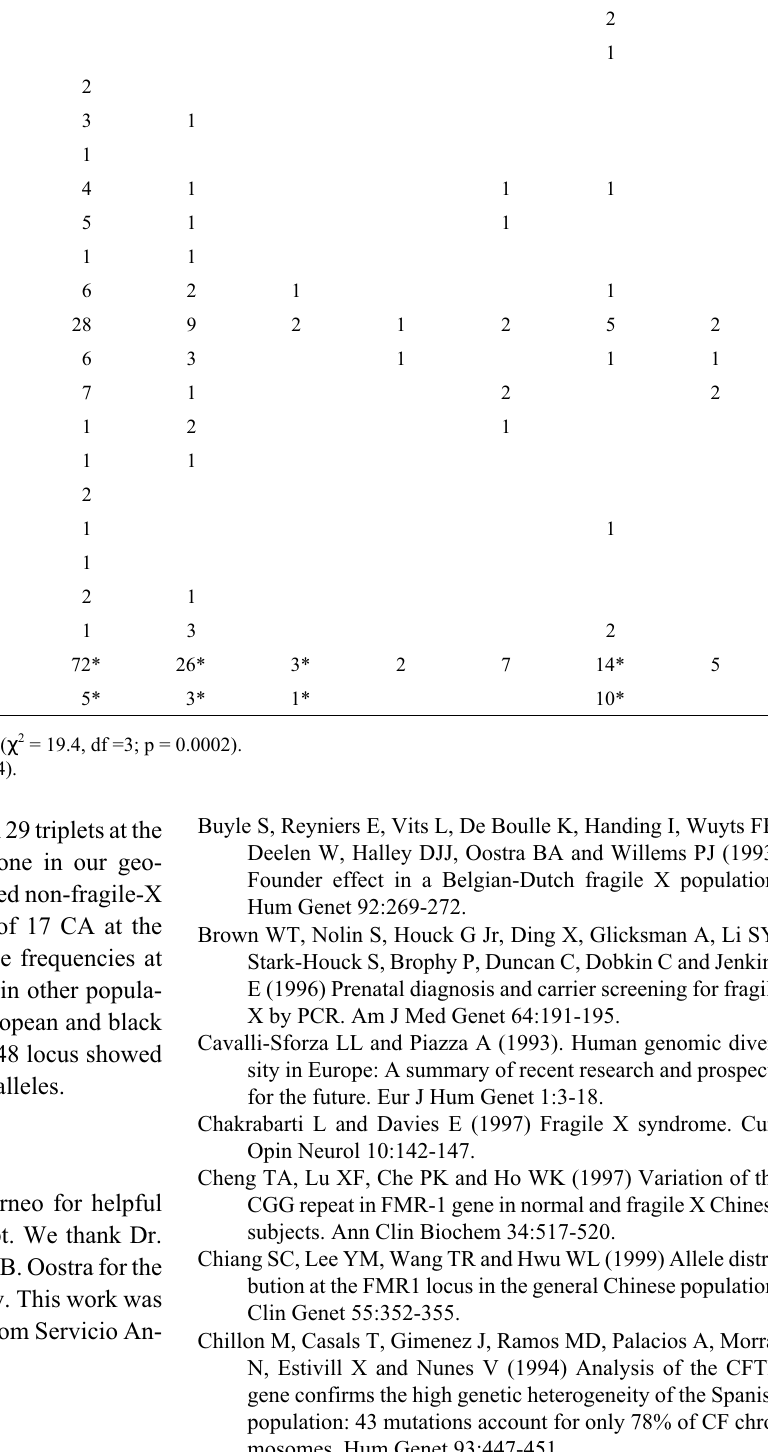
Table II - DXS548-FRAXA haplotypes in the mentally retarded population of Andalusia. Fraxa Alleles